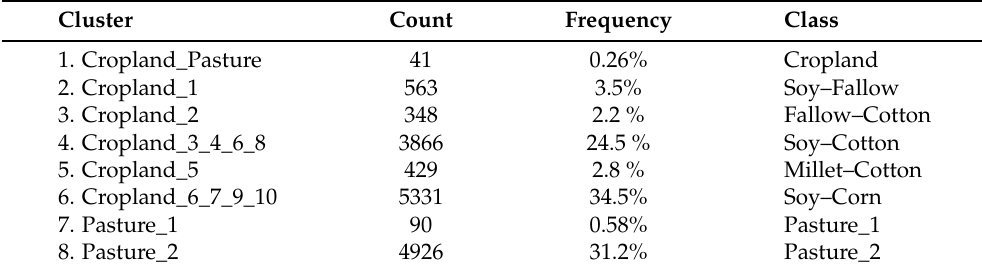
Table 1. Number of training samples by cluster.